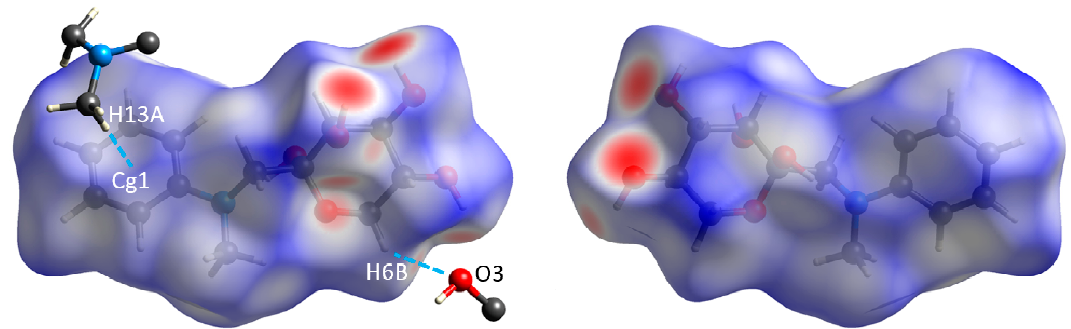
Figure 5. Views of the Hirshfeld surface for N -(1-deoxy- α - D -tagatopyranos-1-yl)- N -methylaniline, with the vdW-normalized contact distance function ( d norm ) mapped in colors encoding intermolecular contacts, from closest (red) to the most distant (blue), in the range of − 0.67 to 1.28. Shown are molecular fragments involved in the C–H··· π interaction and the shortest C–H···O contact.